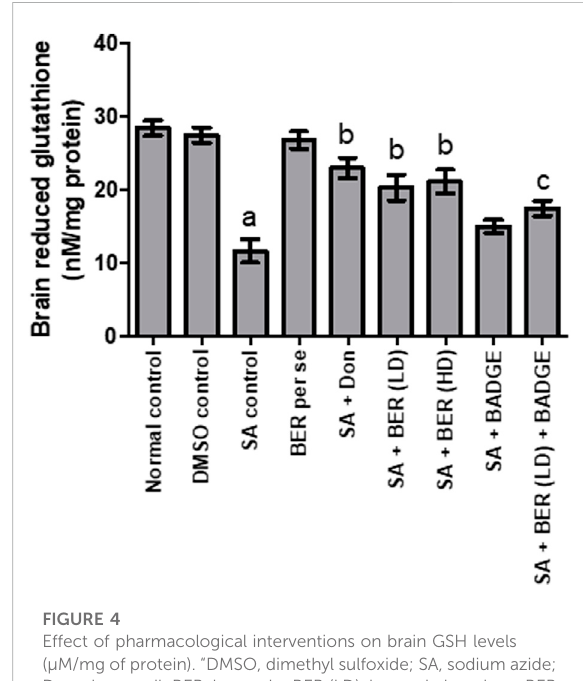
FIGURE 4 Effect of pharmacological interventions on brain GSH levels ( μ M/mg of protein). “ DMSO, dimethyl sulfoxide; SA, sodium azide; Don, donepezil; BER, bergenin; BER (LD), bergenin low dose; BER (HD), bergenin high dose; BADGE, Bisphenol A diglycidyl ether ” (Mehra et al., 2015). “ Each group ( n = 6) represents mean ± S.E.M, a = p ˂ 0.05 vs. normal control, b = p ˂ 0.05 vs. normal control, c = p ˂ 0.05 vs. SA control. One way ANOVA followed by Bonferroni ’ s multiple range test ” (Gulati and Singh,